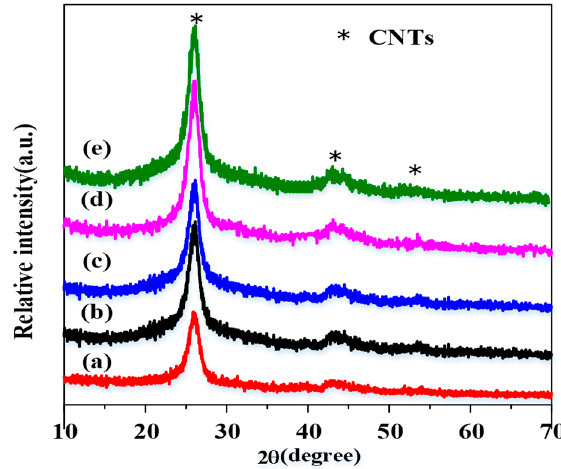
Figure 1. XRD patterns of ( a ) CNTs; Pd/CNTs with different Pd composition ( b ) 0.9 wt%, ( c ) 2.1 wt%, ( d ) 3.0 wt% and ( e ) 4.1 wt%.